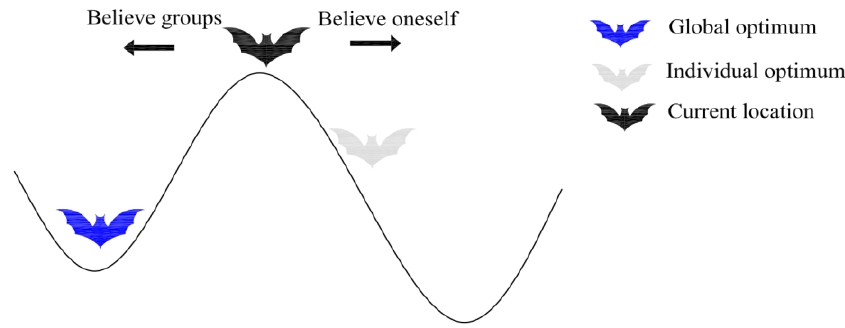
Figure 2. The influence of the individual optimum.